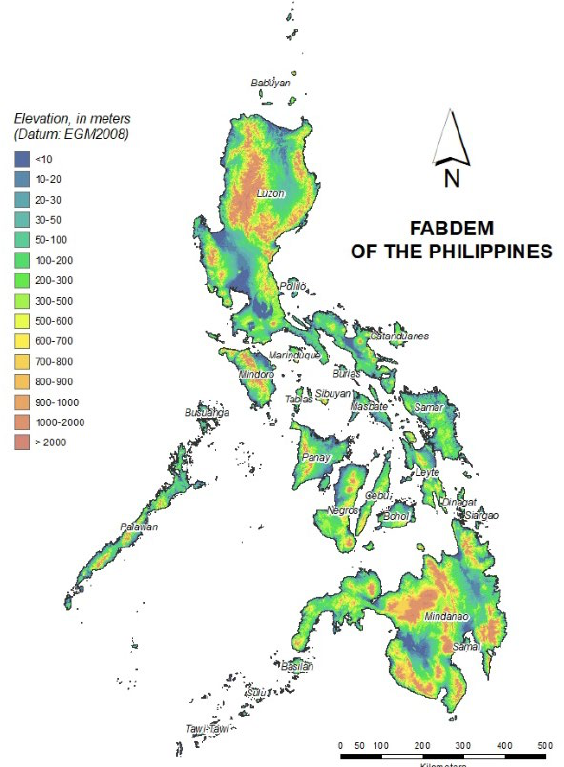
Figure 1 . FABDEM-derived elevation map of the Philippines. Original data source: Hawker and Neil (2021).